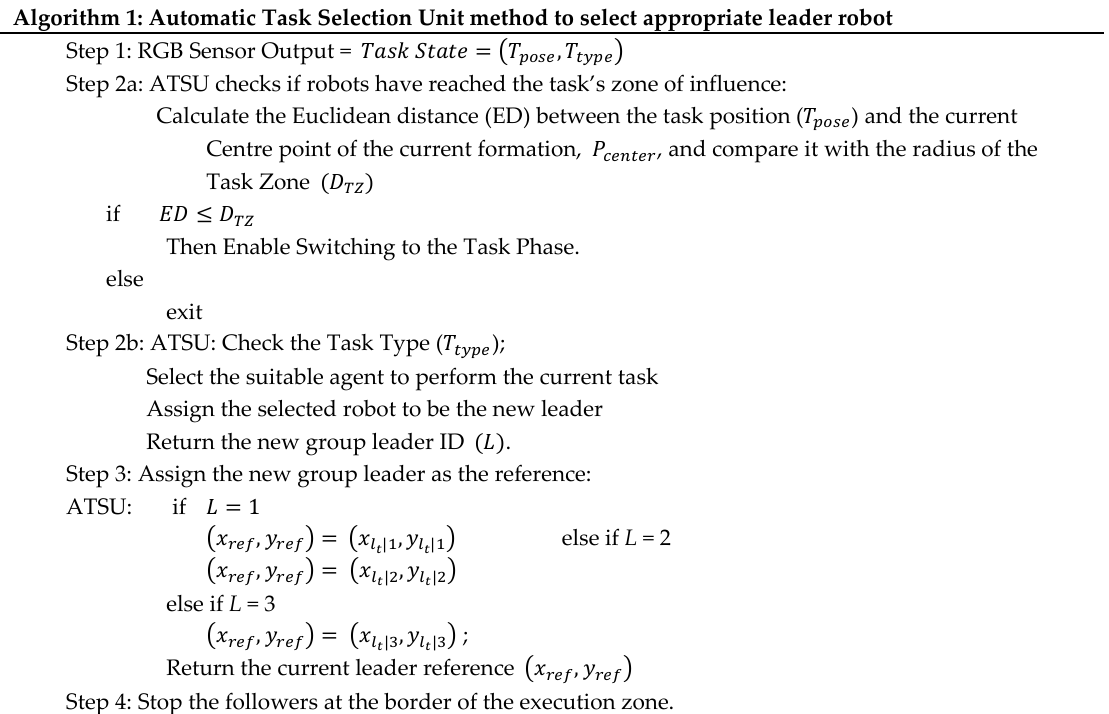
Algorithm 1: Automatic Task Selection Unit method to select appropriate leader